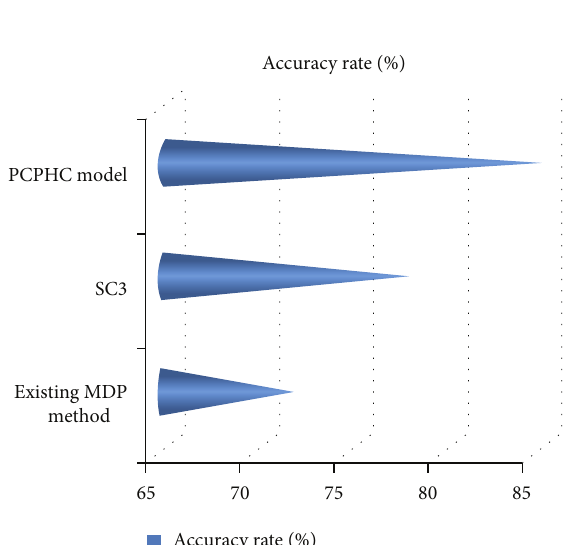
Figure 4: Measure of pattern quality level.